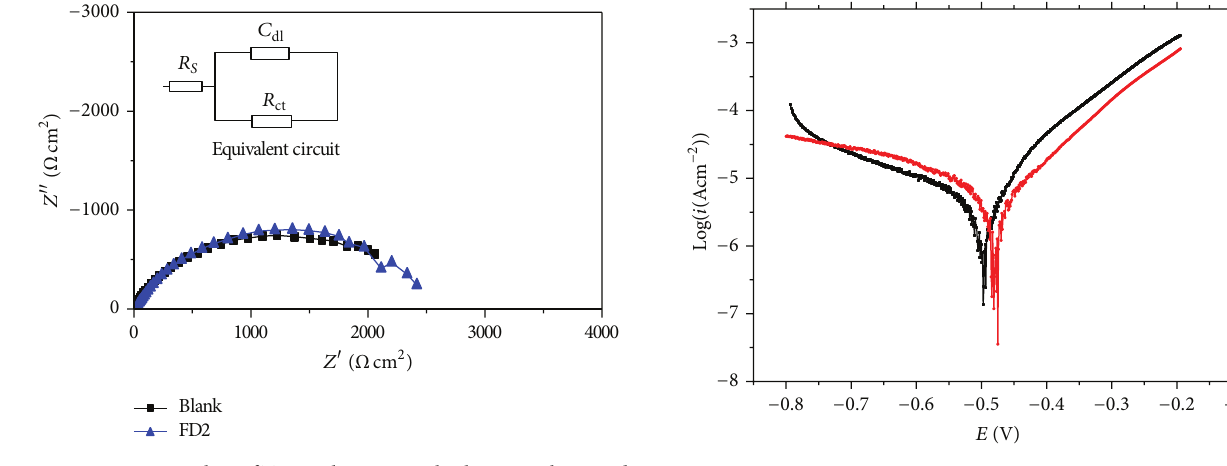
Figure 7: Nyquist plots of T91 steel in 3%NaCl solution without and with 0.1 𝜇 M FD2. Table 1: Electrochemical parameters for T91 steel in 3% NaCl solution.